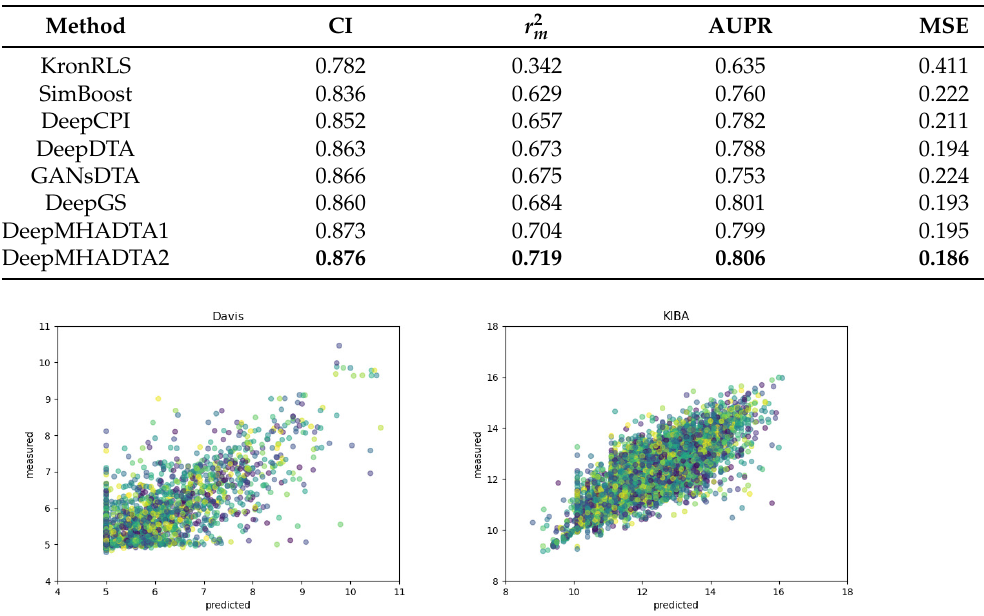
Figure 1. Scatter plots between the predicted and measured binding affinity